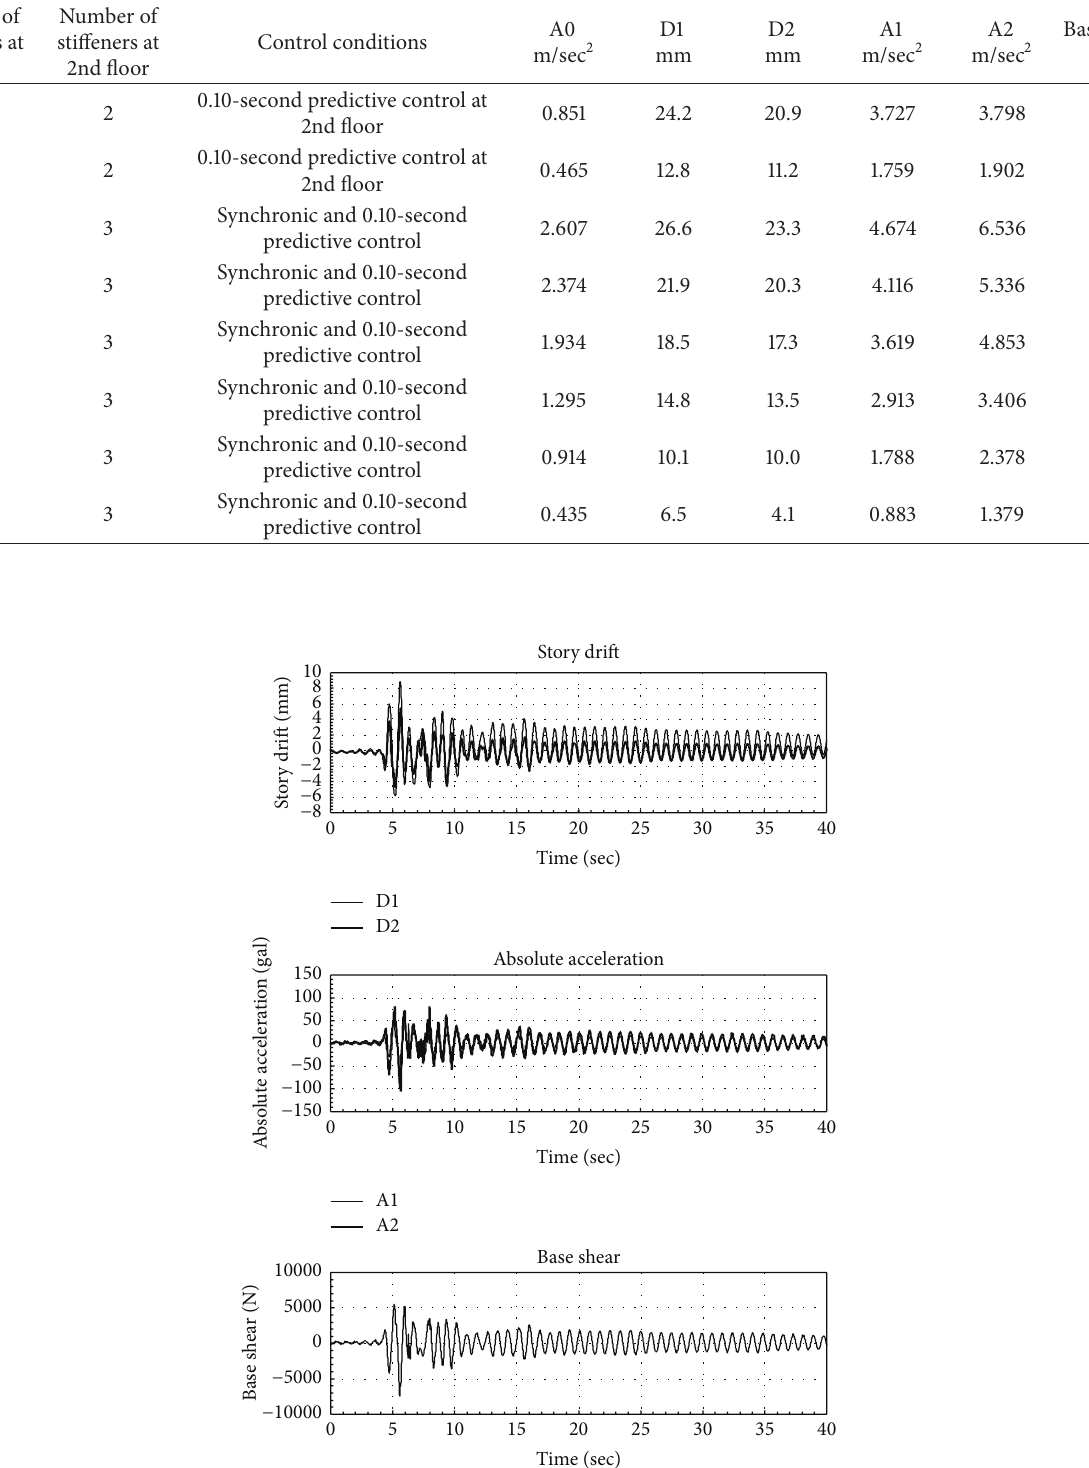
Figure 7: Time history of story drift, absolute acceleration, and base shear responses of test structure added with two stiffeners and with synchronic and 0.13-second predictive control under excitation of Kobe earthquake record with PGA = 0.50 m/sec 2 (50